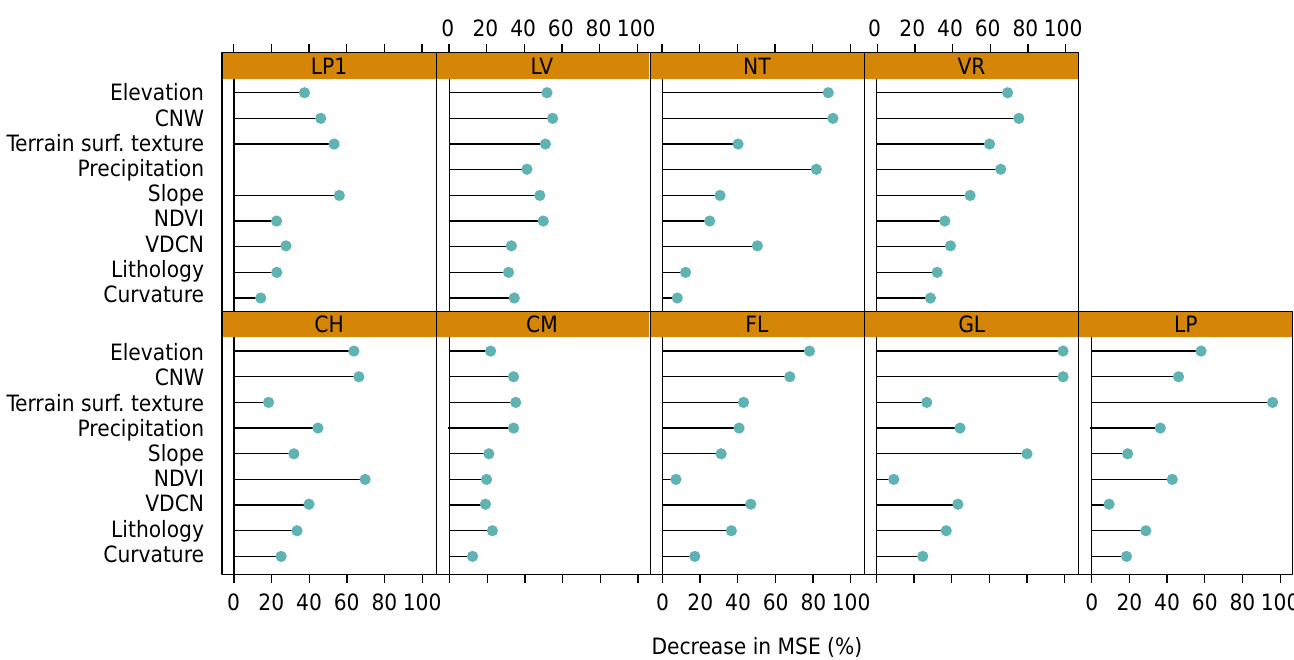
Figure 6. Importance of the covariates in mapping soils by the Random Forest classifier. LP1 = Leptosols + rocky outcrops; LV = Luvisols + Chernozems; NT = Nitisols + Leptosols; VR = Vertisols + Chernozems; CH = Chernozems; CM = Cambisols + Fluvisols; FL = Fluvisols; GL = Gleysols; LP = Leptosols.